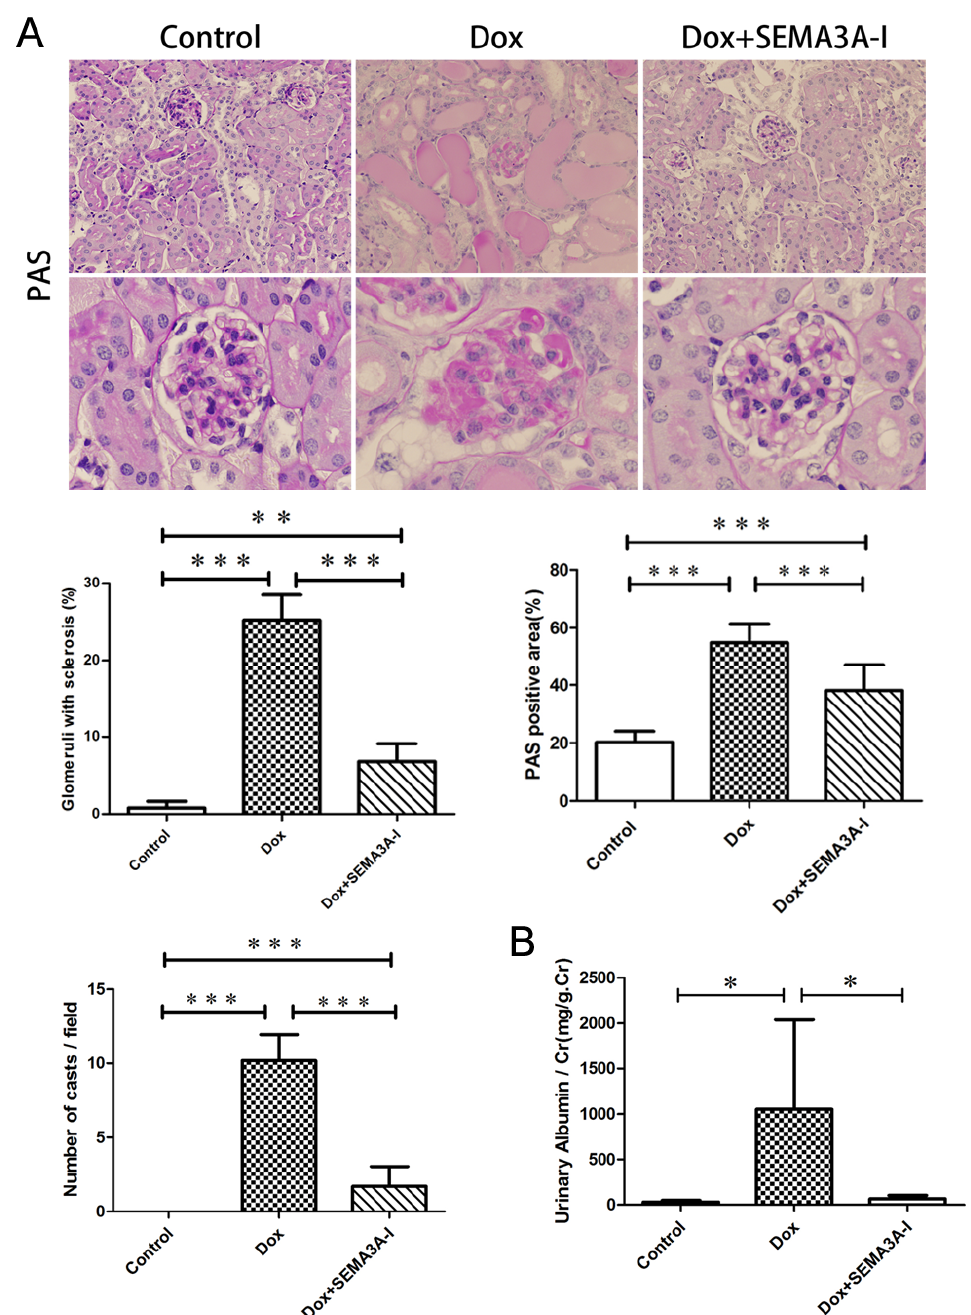
Figure 2. Inhibition of SEMA3A protected against Doxorubicin-induced podocyte injury and albuminuria. ( A ) Histological manifestations are determined by periodic acid-Schi ff (PAS) staining to assess the glomerular injury in the control, Dox, and Dox + SEMA3A-I groups at the time point of 2 weeks after Dox injection. Glomerular structure and podocytes were severely damaged with tubular casts in the Dox group compared to the control and Dox + SEMA3A-I groups. Representative images are shown. Original magnification, × 200 (upper panel), × 400 (lower panel). The PAS-positive area / glomeruli (%), the ratio of glomeruli with sclerosis (%), and the number of tubular casts / 200 × fields are shown in the graphs. ** p < 0.01, *** p < 0.001 . ( B ) Mouse urinary albumin / creatinine ratio in the control, Dox, and Dox + SEMA3A-I groups at the time point of 2 weeks after Dox injection, showing higher levels of urinary albumin in the Dox group compared to the control and Dox + SEMA3A-I groups. Analysis was conducted by the Wilcoxon test. * p < 0.05.